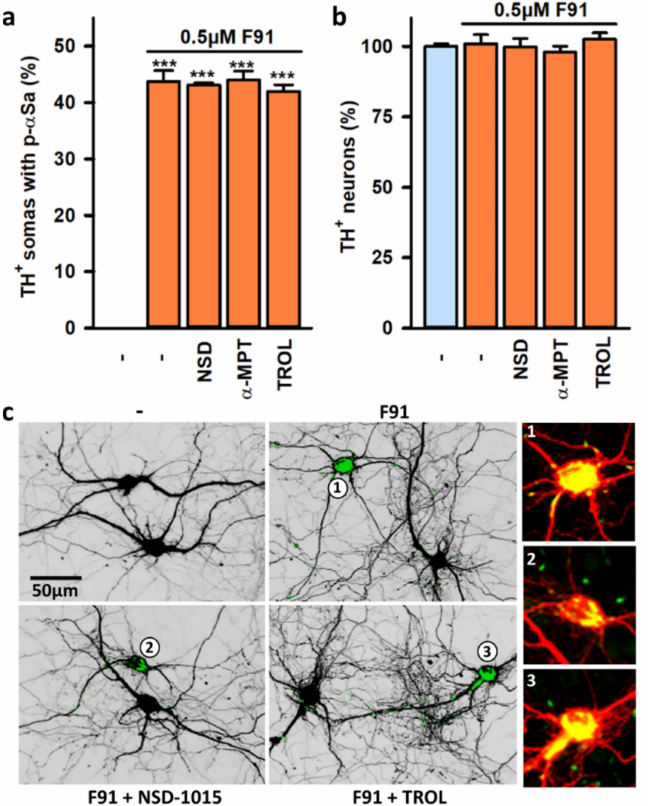
Figure 5. Impact of DA synthesis/catabolism on α S seeded aggregation in midbrain DA neurons in culture. ( a ) Number of TH + neurons with somal α Sa in three-week midbrain cultures treated or not treated two weeks before with 0.5 µ M F91 in the presence or absence of the AADC inhibitor NSD-1015 (20 µ M), the TH inhibitor α -MPT (50 µ M) or the antioxidant Trolox-C (TROL; 10 µ M). Data are means ± SEM ( n = 4–8). *** p < 0.001 vs. controls. One-way ANOVA followed by Dunnett’s test. ( b ) Counts of TH + neurons in cultures exposed to the same treatments as in ( a ). Data are means ± SEM ( n = 4–8). ( c ) Z-projection confocal images showing the presence of α Sa in the soma of TH + neurons in midbrain cultures exposed to the same treatments as in ( a ). TH + neurons are presented under an inverted black and white format and the immunosignal for p- α S corresponds to the green label. An enlarged version of the annotated TH + cell bodies (red; 1–3) with large aggregates (yellow after merging red and green) is presented under a standard fluorescent